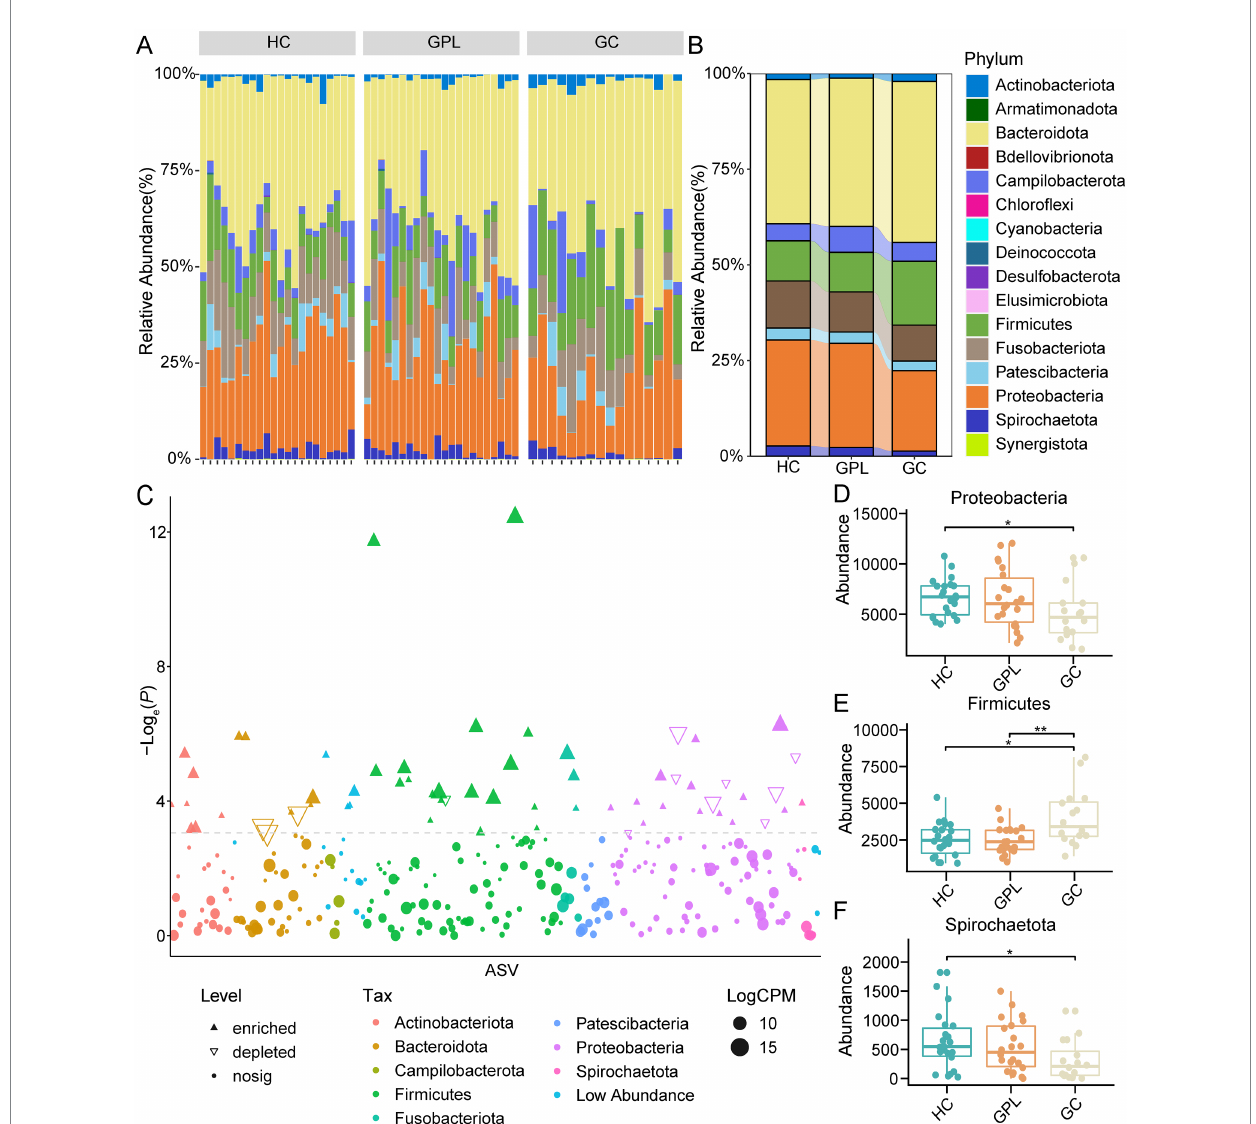
FIGURE 2 The relative abundances of taxonomy at the phylum level. (A) The relative abundances of taxonomy at the phylum level in all samples (60). (B) The relative abundances in phylum level in three groups. (C) Demonstration of precancerous lesions gastric cancer (GPL/GC) versus bacterial group with healthy control (HC). X -axis for ASVs, alphabetically ordered by taxonomic phylum level; Y -axis p value values for the comparison of the two groups, taken as log e ( P ), i.e., natural logarithmic transformation; the size of the nodes in the graph represents the relative abundance of that ASV, taken as log 2 (CPM), the logarithm of 2; CPM is an abbreviation for count per million, which being fractions of a million; different nodes colors represent different phylum; the shape of the nodes in the graph marks the type of its change, whether it is up-regulated enriched (positive solid triangle), down-regulated depleted (inverted hollow triangle), or no significant difference change nosig (solid nodes). Differences abundance at the phylum level among groups (Wilcox. test, * p < 0.05, ** p < 0.01), Proteobacteria (D) , Firmicutes (E) , Spirochaetota (F)